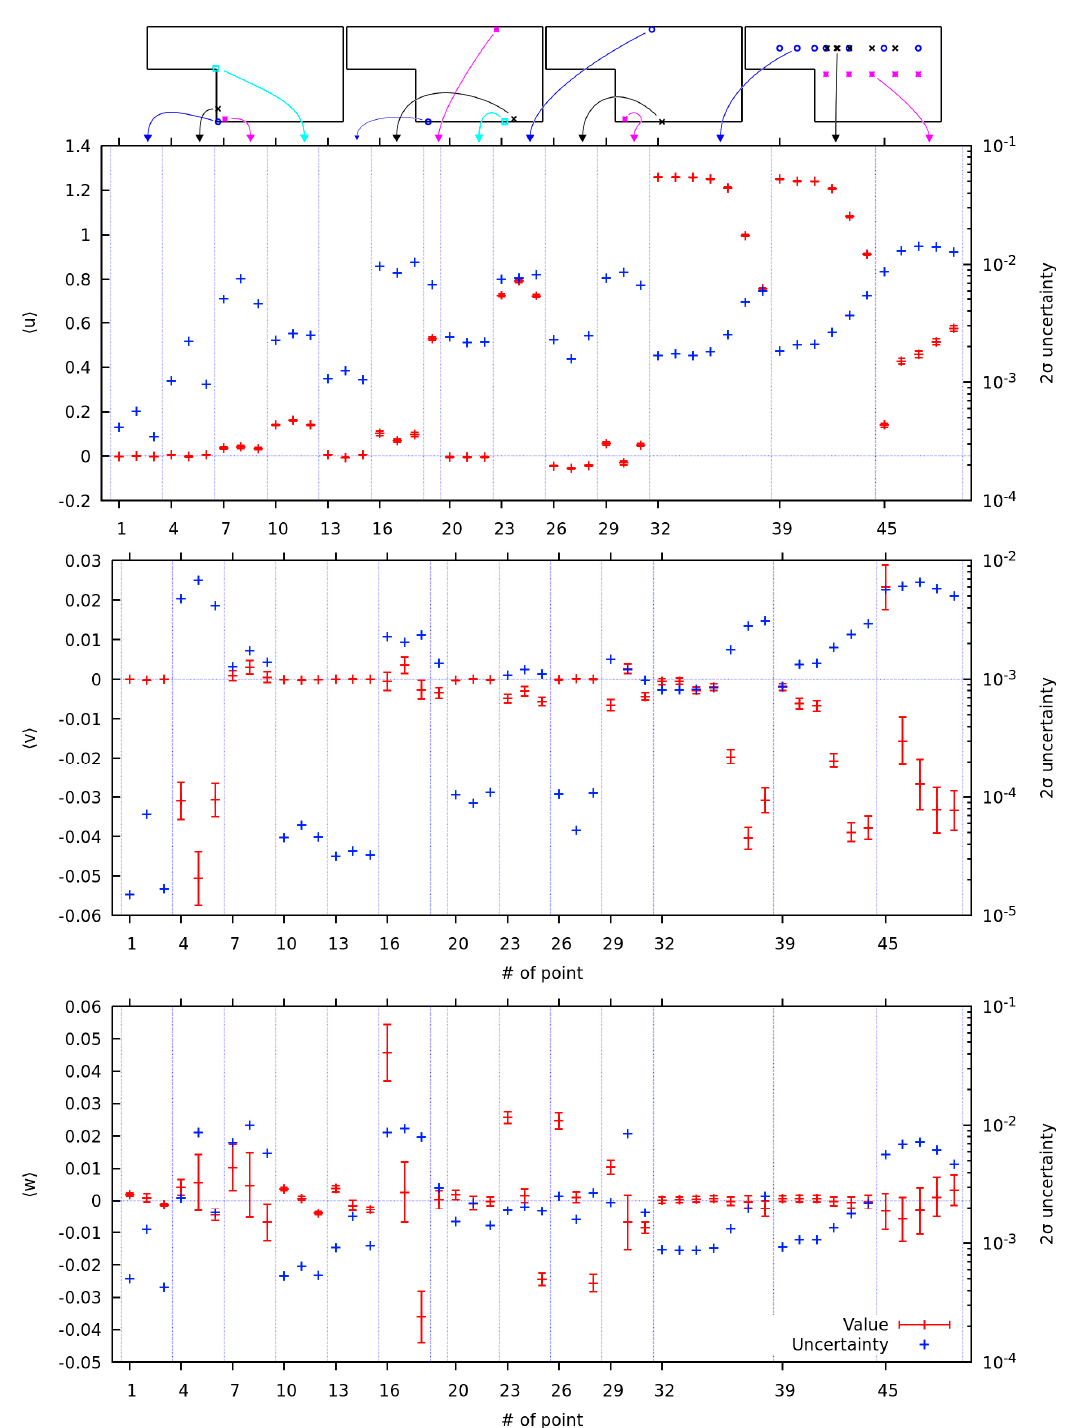
Figure 11. x -axis: number of point according to Figure 2. Top: Mean x -direction velocity. Middle: y -direction velocity. Figure 11. 𝑥 -axis: number of point according to Figure 2. Top: Mean 𝑥 -direction velocity. Middle: 𝑦 -direction velocity. Bottom: 𝑧 - Bottom: z -direction velocity. Red dots represent average values with ± 2 σ range (left scale), blue dots represent (2 σ ) direction velocity. Red dots represent average values with ± 2𝜎 range (left scale), blue dots represent ( 2𝜎 ) uncertainty (right uncertainty (right scale).